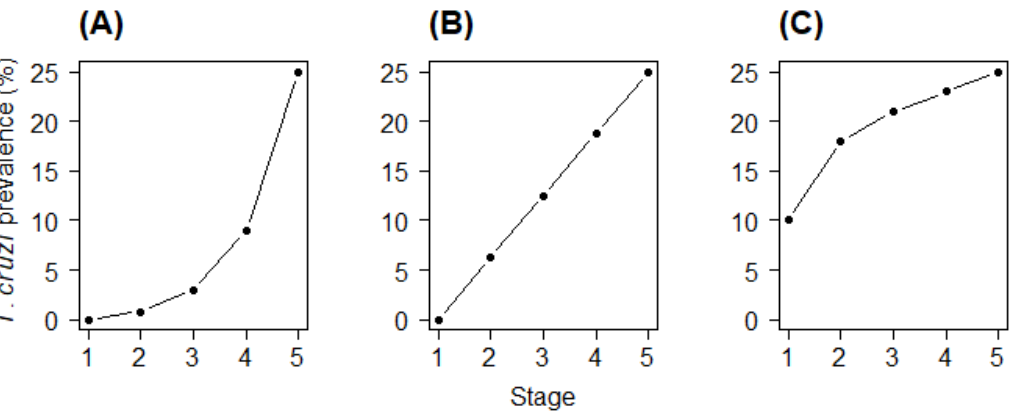
Figure 1. Hypothetical shapes of the relationship between triatomine stage and prevalence of infection with Trypanosoma cruzi under three hypotheses. ( A ) Acquisition of the parasite depends upon the quantity of blood ingested (Blood Hypothesis); ( B ) Parasite acquisition depends upon the number of exposure opportunities (Bites Hypothesis); ( C ) Early instar nymphs frequently acquire the parasite via coprophagy, while older instars acquire the parasite at a lower rate via ingestion of blood from mammalian hosts (Coprophagy Hypothesis). Note: the scale of the vertical axis is for illustrative purpose only and does not correspond to actual data; rather, panels ( A ) through ( C ) demonstrate three different theoretical shapes that could each produce 25% prevalence in fifth instars.